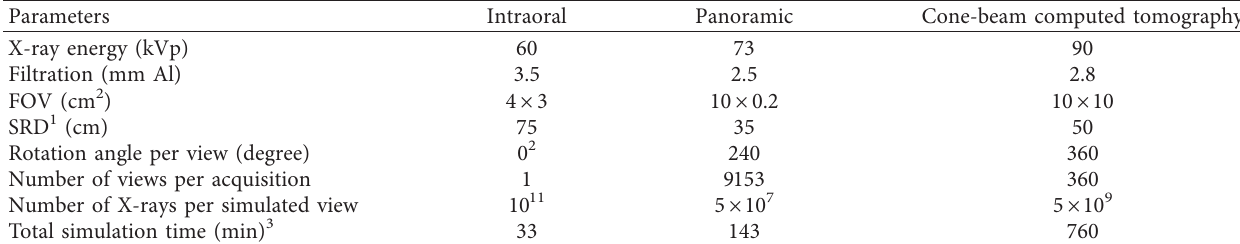
Table 1: Technical parameters for intraoral, panoramic, and cone-beam computed tomography collected from literature, which were used for Monte Carlo simulations conducted using MC-GPU to estimate dose distribution within the head.